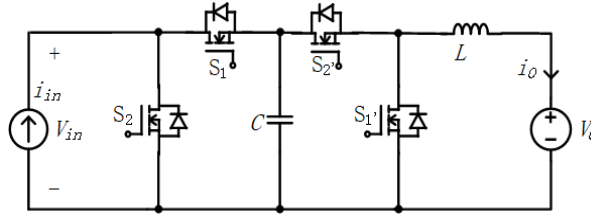
Figure 10. A current-fed buck-boost converter.